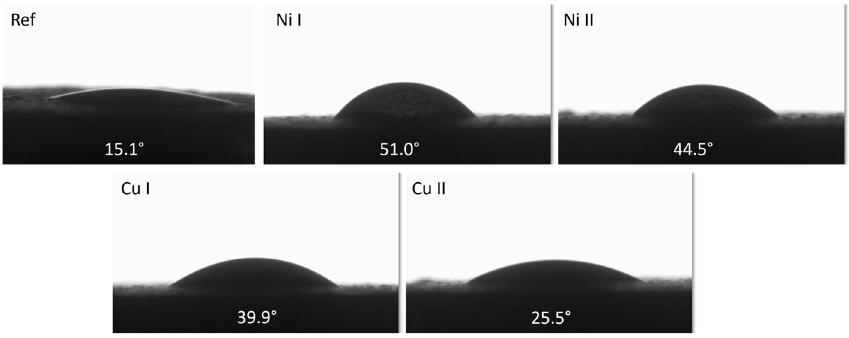
Figure 7. Contact angles and water drop views on prepared samples surface.